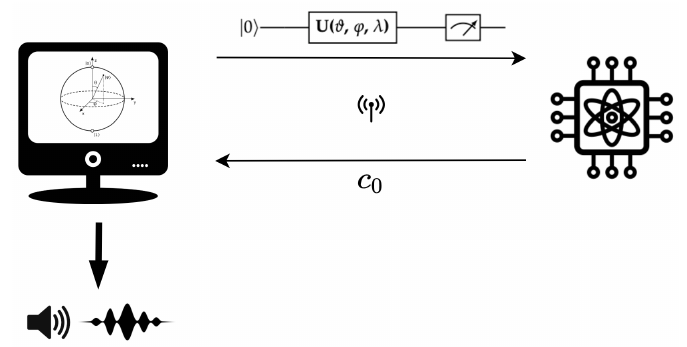
Figure 4. For measurement, Q1Synth builds a quantum circuit and sends it to a quantum computer over the